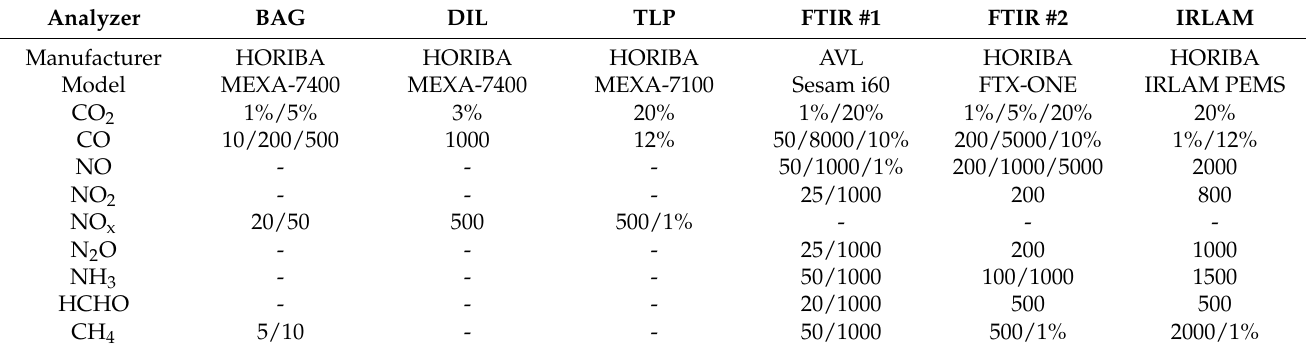
Table A1. Indicative measurement ranges.